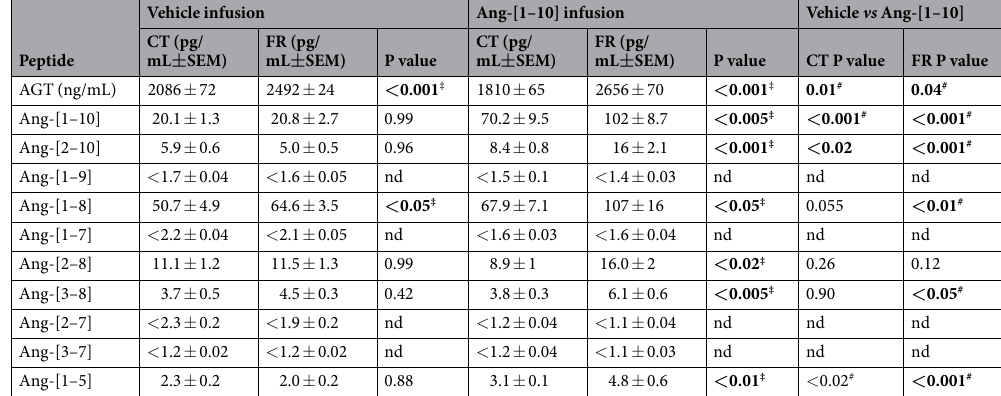
Table 2. Effect of food restriction on plasma angiotensin peptides before and after Ang-[1–10] infusion. Blood angiotensinogen (n = 8/group) and angiotensin (Ang) peptide concentrations before (CT, n = 10; FR, n = 11/ group) and after Ang-[1–10] infusion (n = 8/group) in female rats subjected to control (CT) or food restricted (FR) diet for 14 days. ‡ P < 0.05 vs CT by two-way ANOVA and Bonferroni post-hoc test (drug; diet); # P < 0.05 vs vehicle, same group , by unpaired Student’s t -test. ( < ) in front of a number indicates below threshold of signal-to-noise; nd, not